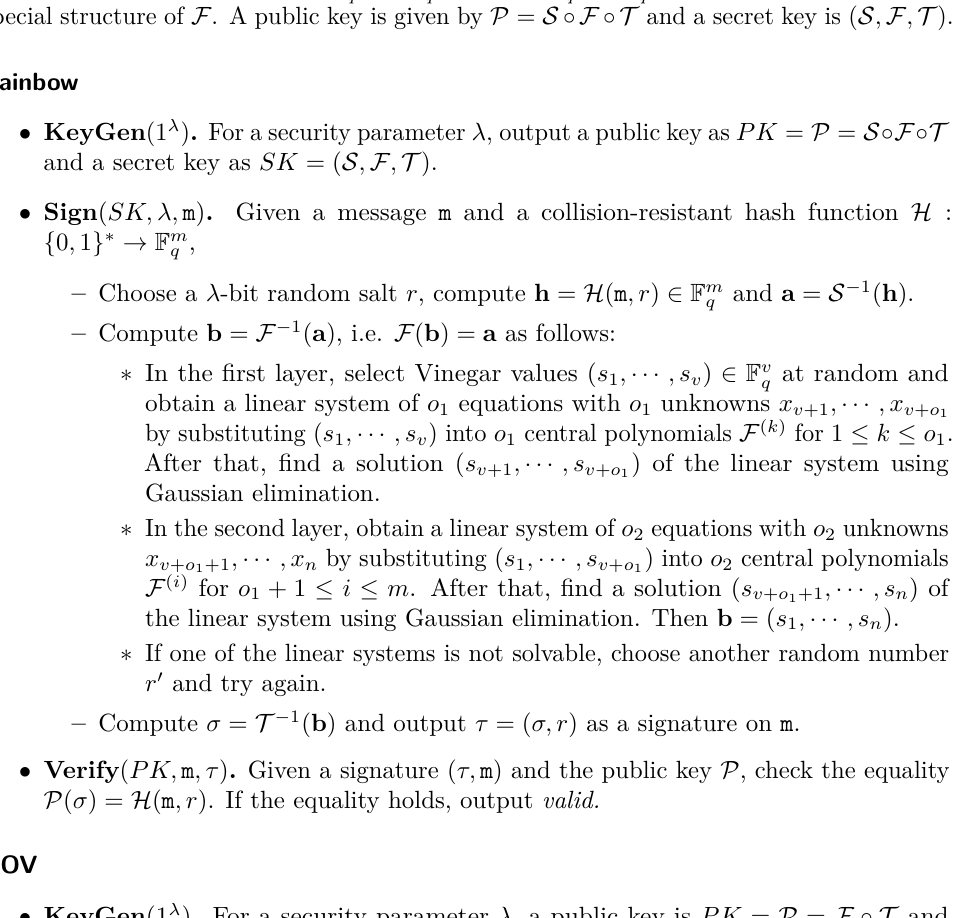
Algorithm 1, Algorithm 2, and Algorithm 3 specify key generation, signing, and verification of Rainbow submitted to NIST PQC Standardization Round 3 [DCP +